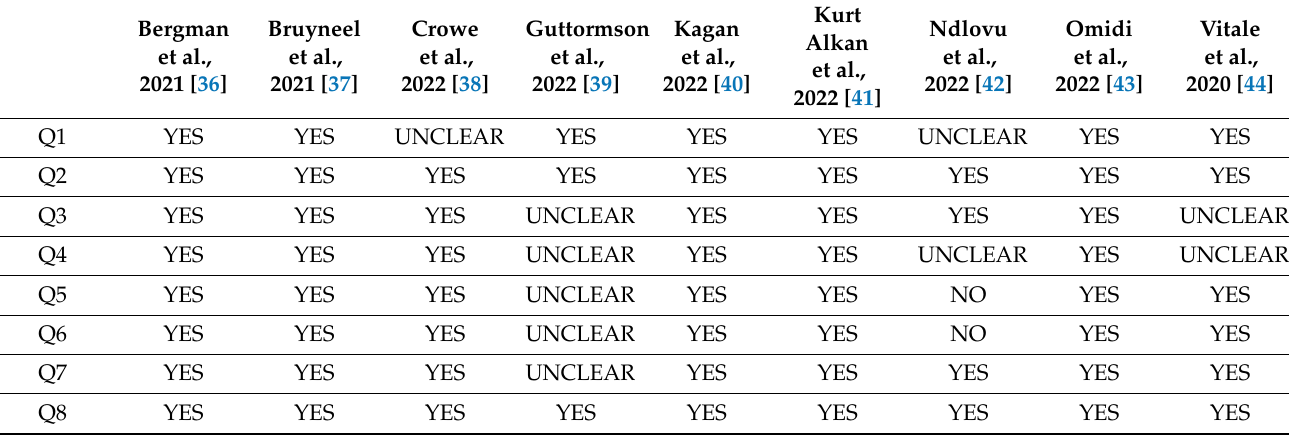
Table 1. Methodological quality assessment of the reviewed studies (quantitative studies/parts).